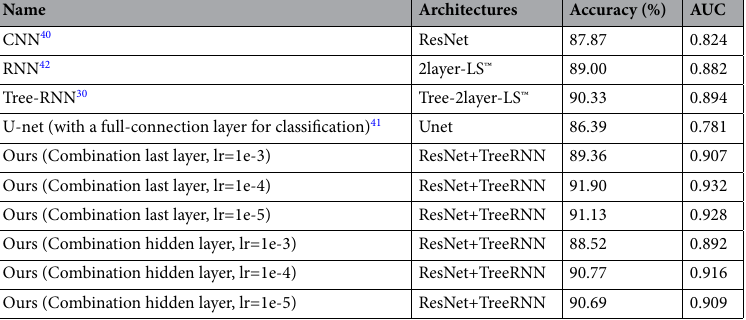
Table 3. The performance of neuron-type classification with different DNN architectures, including accuracy and the area under the curve